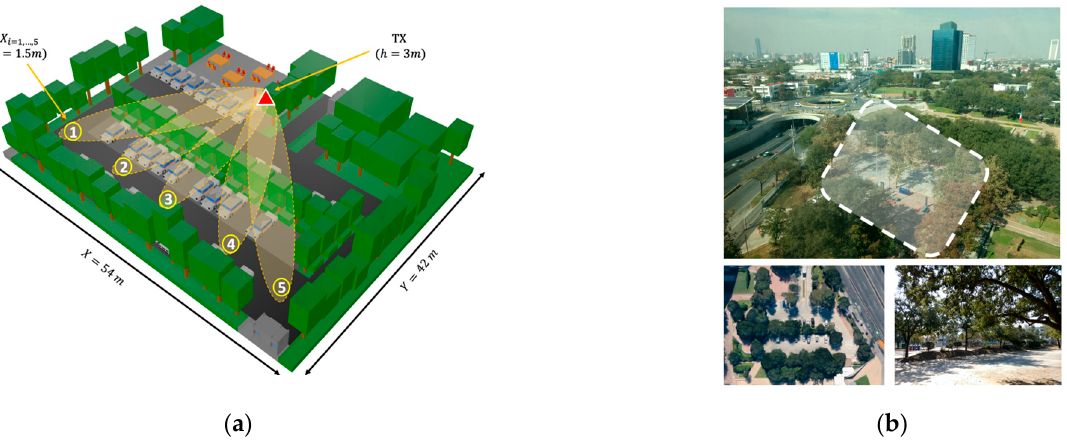
Figure 1. General and detailed view of the simulated 3D scenario: ( a ) rendered view of the scenario; ( b ) real scenario photos with the consideration of scatterers as vegetation and vehicles, among others.